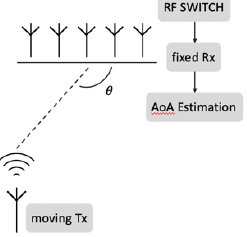
Figure 1 . Bluetooth 5.1 AoA